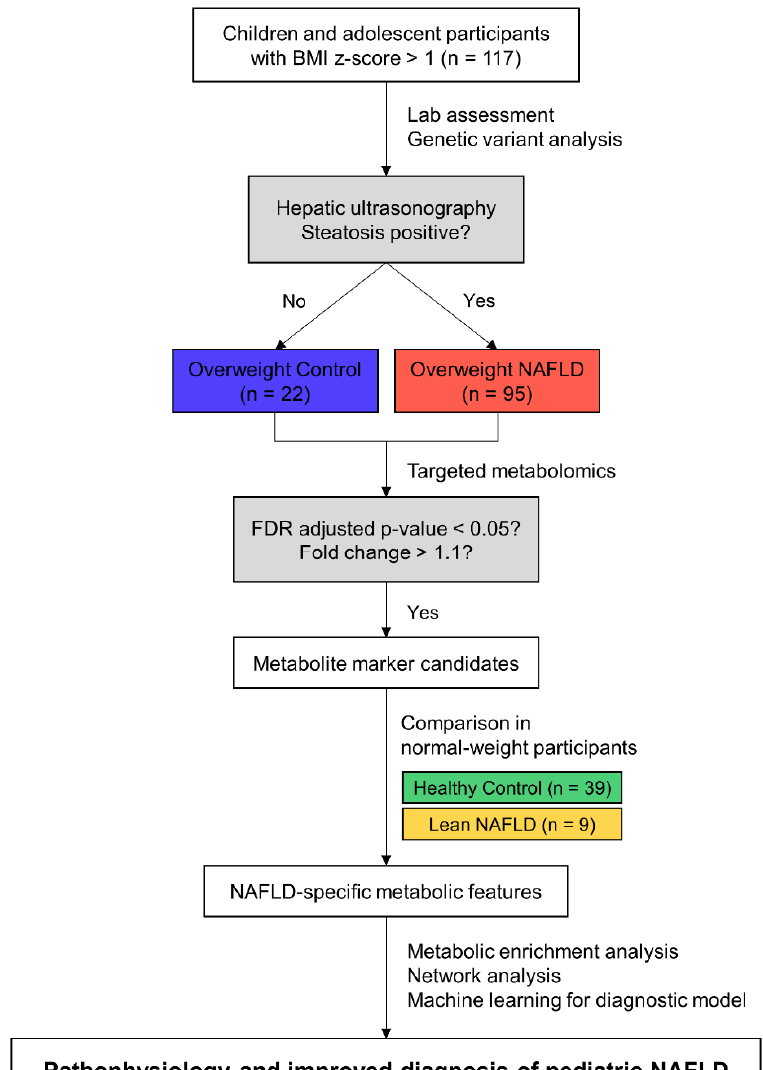
Figure 1. Schematic study design and analysis workflow. Abbreviations: BMI, body mass index; FDR, false discovery rate.